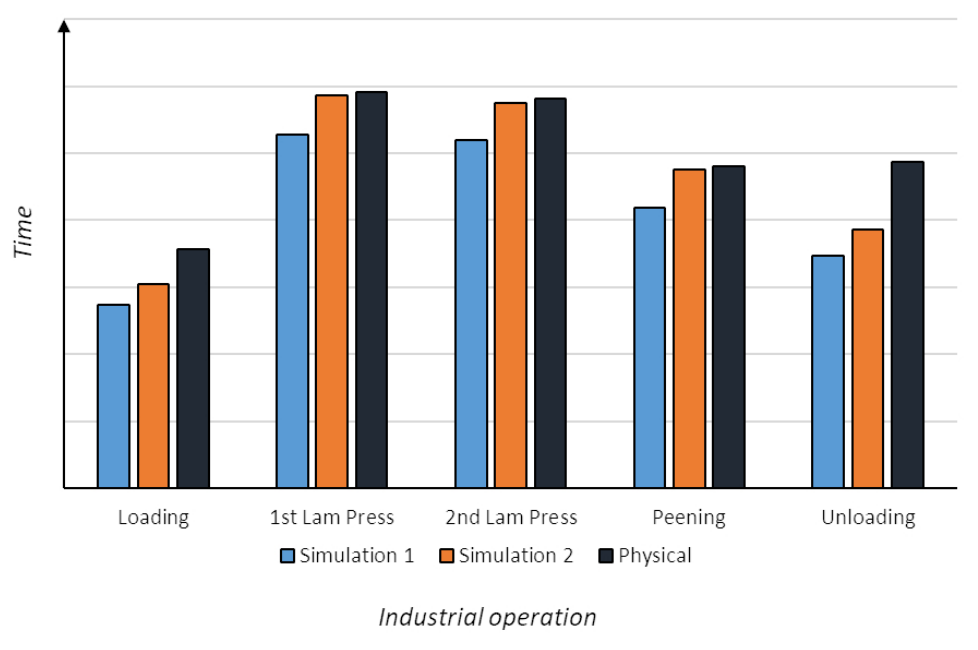
Figure 11. Comparison of cycle time in the simulations and actual physical industrial processes. Table 1. The average difference between the simulation cycle time and the physical process.